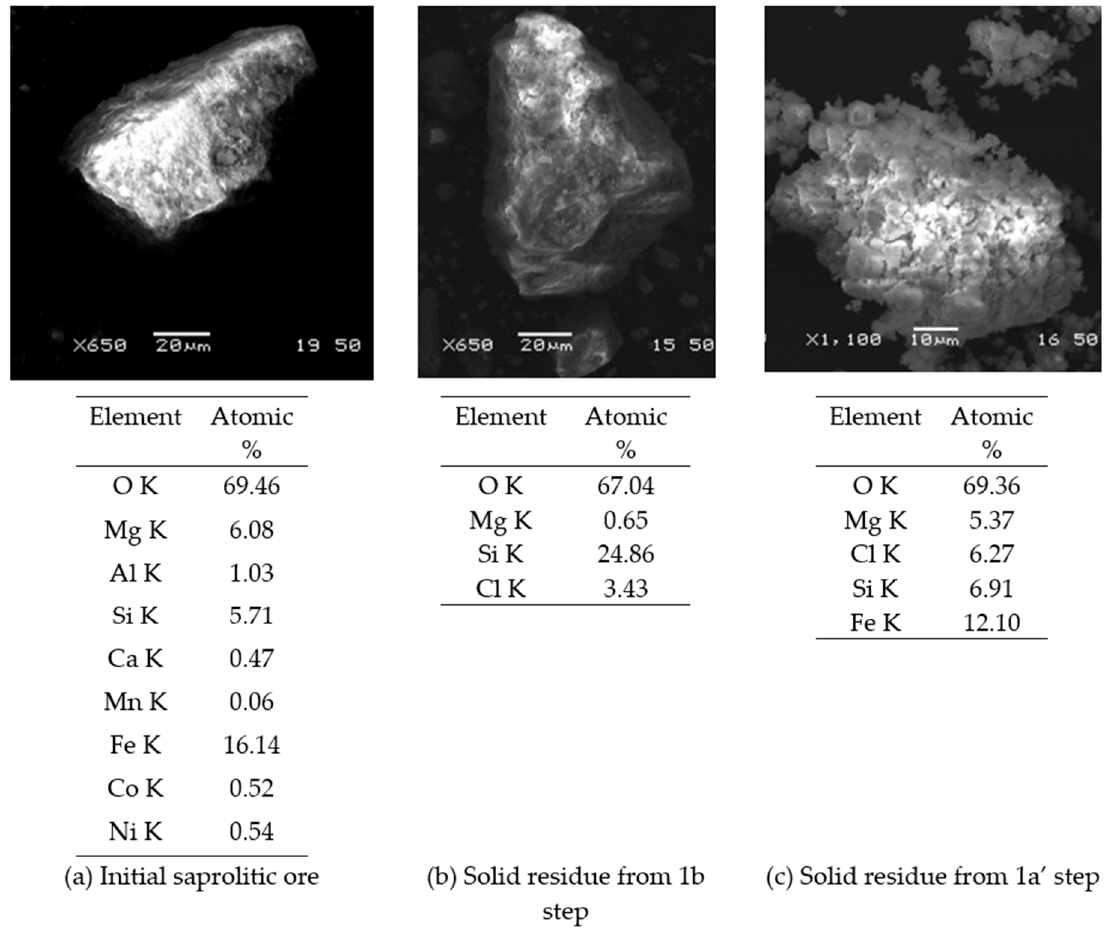
Figure 4. SEM microphotographs and energy-dispersive X-ray spectroscopy (EDS) analyses of ( a ) initial grains, ( b ) grains after CCL step 1b, and ( c ) grains after CCL step